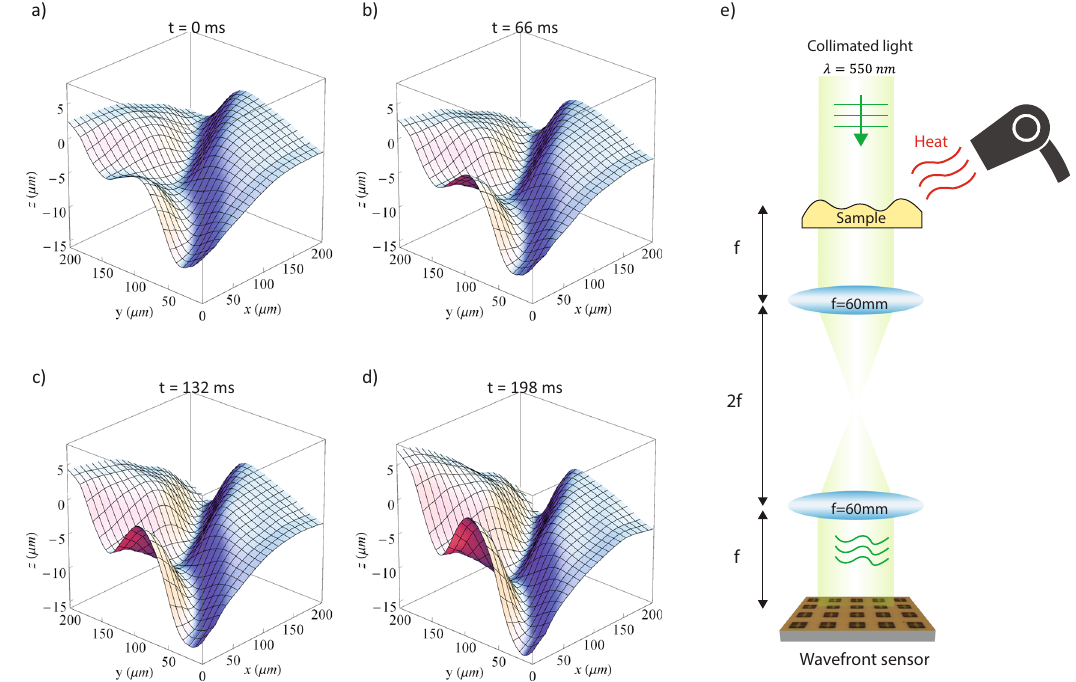
Fig. 5 Surface topography in video-frame rate. a – d Selected time lapse of a surface pro fi le captured at a video-frame rate. Sample is a PMMA polymer on a transparent microscope slide that goes through a fast coagulation process, while its temperature increases. e Measurement setup for a video-frame rate measurement. Optical setup is same as that in Fig. 4b. A heat gun is used to increase the temperature of a PMMA polymer on a microscope